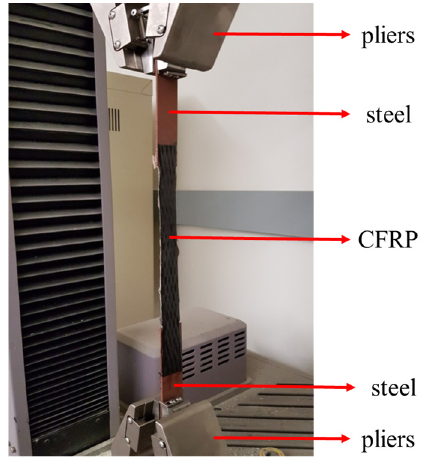
Figure 9. Laboratory setup for the lap shear test.